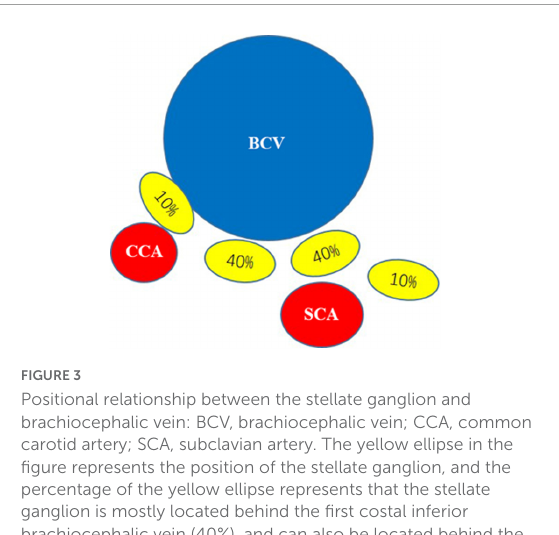
FIGURE3 Positional relationship between the stellate ganglion and brachiocephalic vein: BCV, brachiocephalic vein; CCA, common carotid artery; SCA, subclavian artery. The yellow ellipse in the figure represents the position of the stellate ganglion, and the percentage of the yellow ellipse represents that the stellate ganglion is mostly located behind the first costal inferior brachiocephalic vein (40%), and can also be located behind the medial side (10%) or post-erolateral side